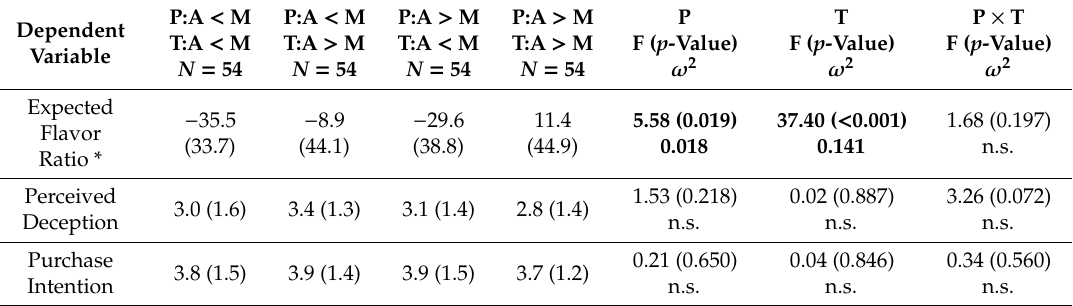
Table 8. ANOVA table with mean (SD) for each condition on the dependent variables including F-values with corresponding significance levels for each main and interaction e ff ect of pictorial (P) and textual (T). Whenever a respondent had an expected flavor ratio greater (smaller) than zero, this means the participant expected the apple flavor of the juice to be more (less) intense compared to the mango flavor of the juice.